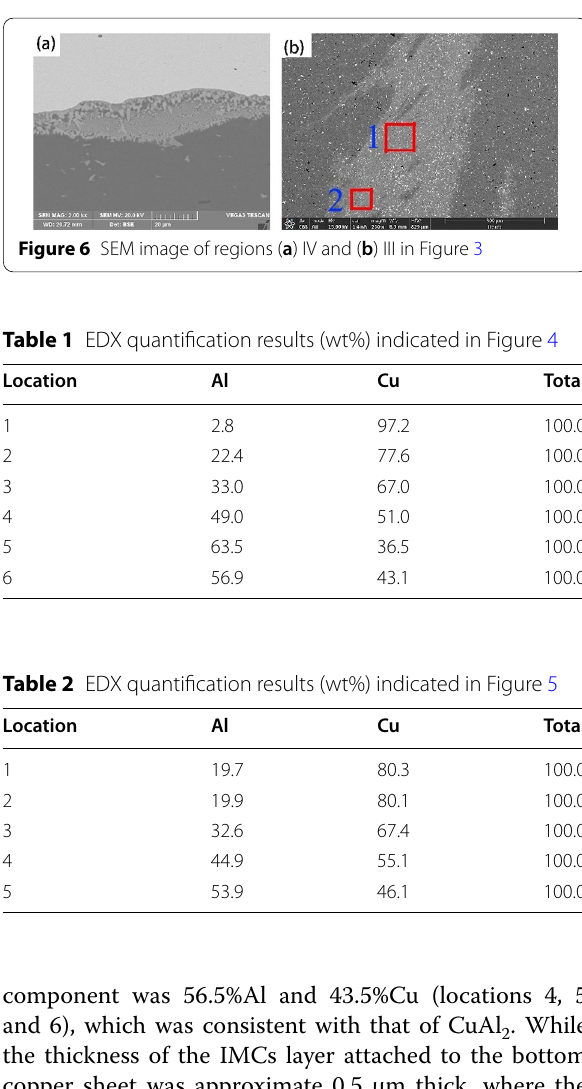
Figure 6 SEM image of regions ( a ) IV and ( b ) III in Figure 3